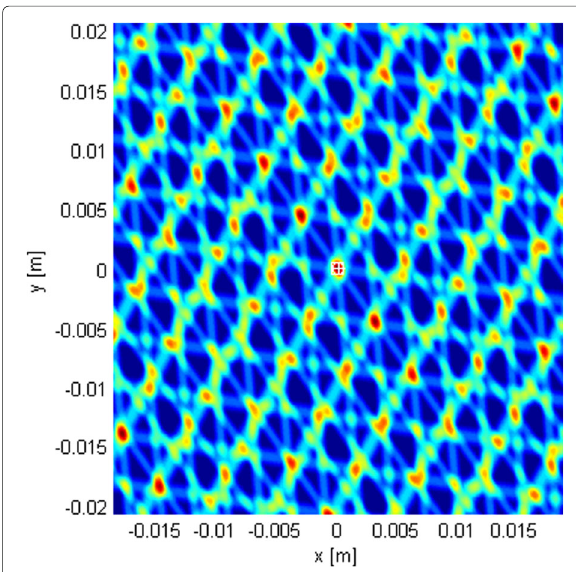
Fig.8 Criterion function of stage 2, given by (31) for G 1 with N =